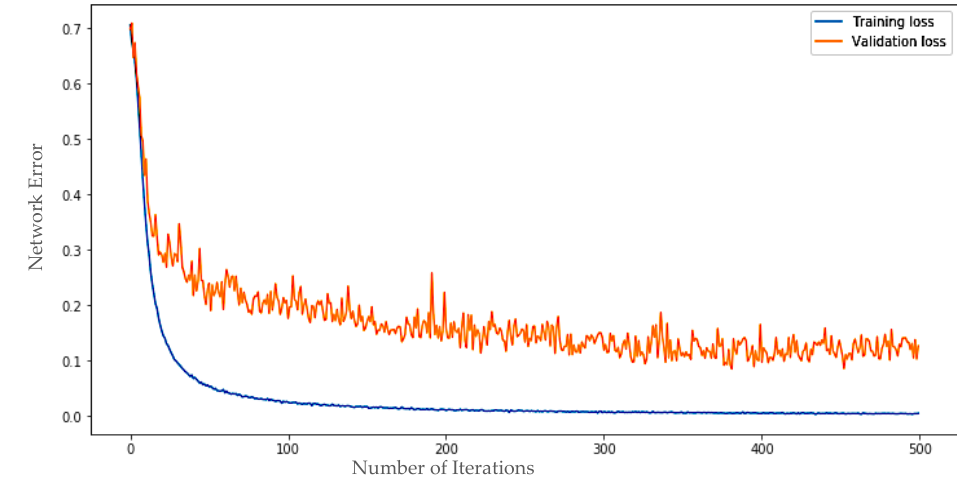
Figure 7. The proposed network error for two-class scenarios for F3 and C3 channels.